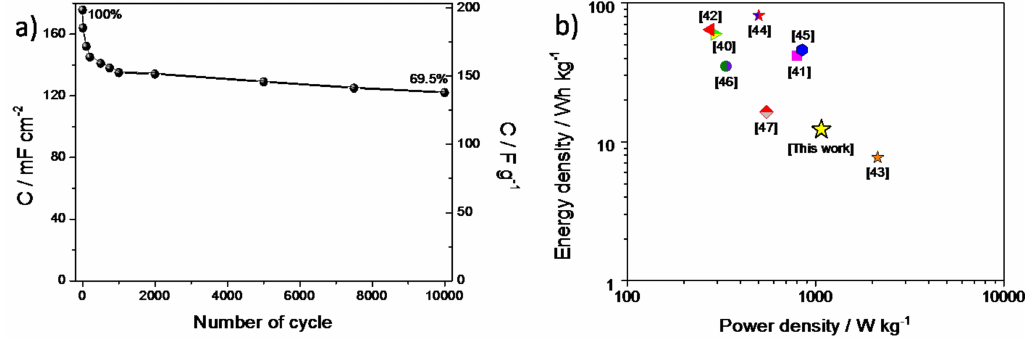
Figure 8. (a )Thecapacitance(arealandgravimetric)vs. numberofcycleplotrecordedforaPANI / WO 3 -based symmetric supercapacitor and ( b ) Ragone plot for a FTO / PANI / WO 3 symmetric Figure 8. a ) The capacitance (areal and gravimetric) vs. number of cycle plot recorded for a PANI/WO 3 -based symmetric supercapacitor and b ) Ragone plot for a FTO/PANI/WO 3 symmetric supercapacitor.